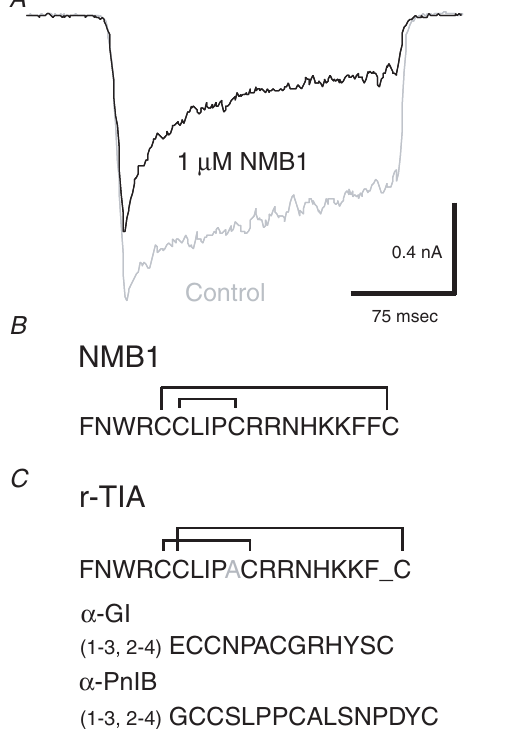
Figure 1. Action and sequence of the conopeptide NMB-1. ( A ) Inhibition of an MA current by 1 m M NMB-1. ( B ) Primary sequence of NMB-1 showing disulfide bridges. ( C ) Conopeptides closely related to NMB-1. Shown are r -TIA (from Conus tulipa ), with differences from NMB-1 indicated, and the a -conopeptides, a -GI ( Conus geographus ) and a -PnIB ( Conus pennaceus ).